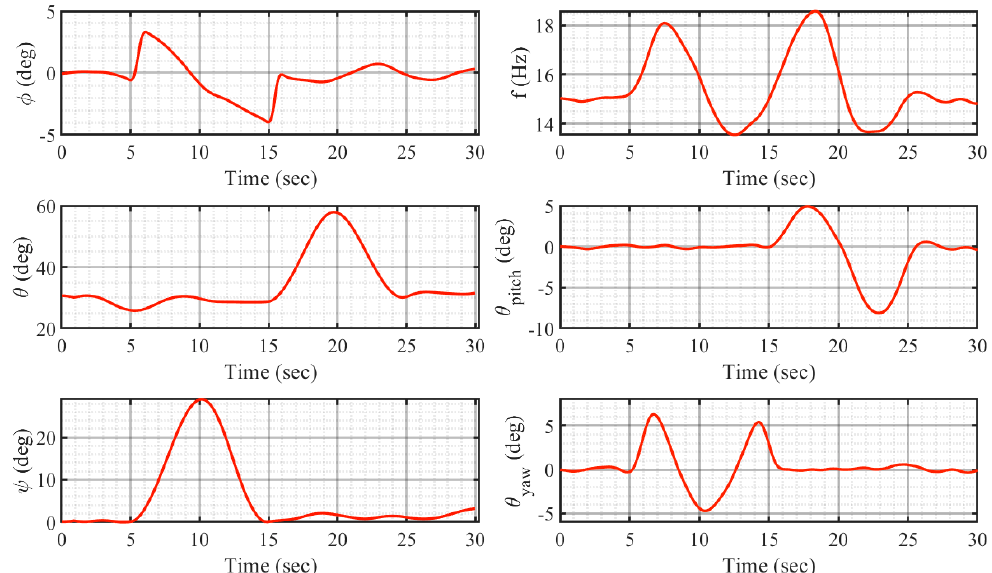
Figure 14. System state during trajectory tracking: Euler angles ( left ), design variables of the actuators ( right ).